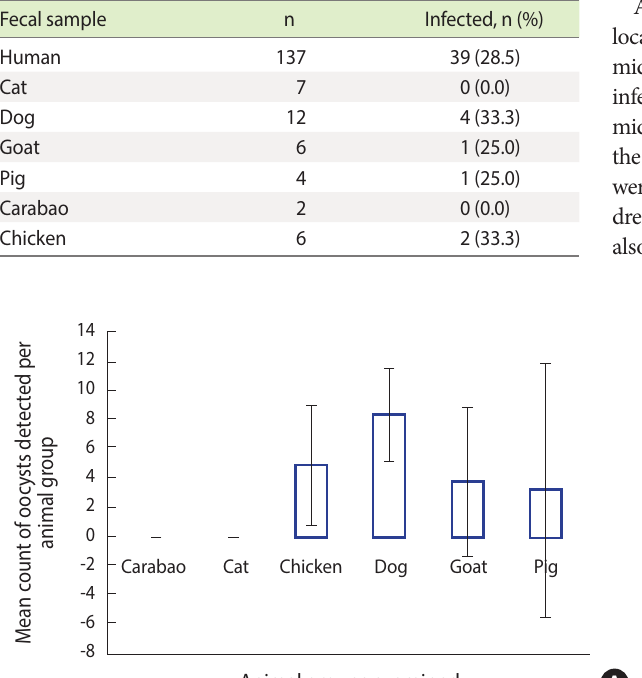
sources.Animal groups examined Figure 2. Mean count of oocysts among (A) animal groups and (B) water